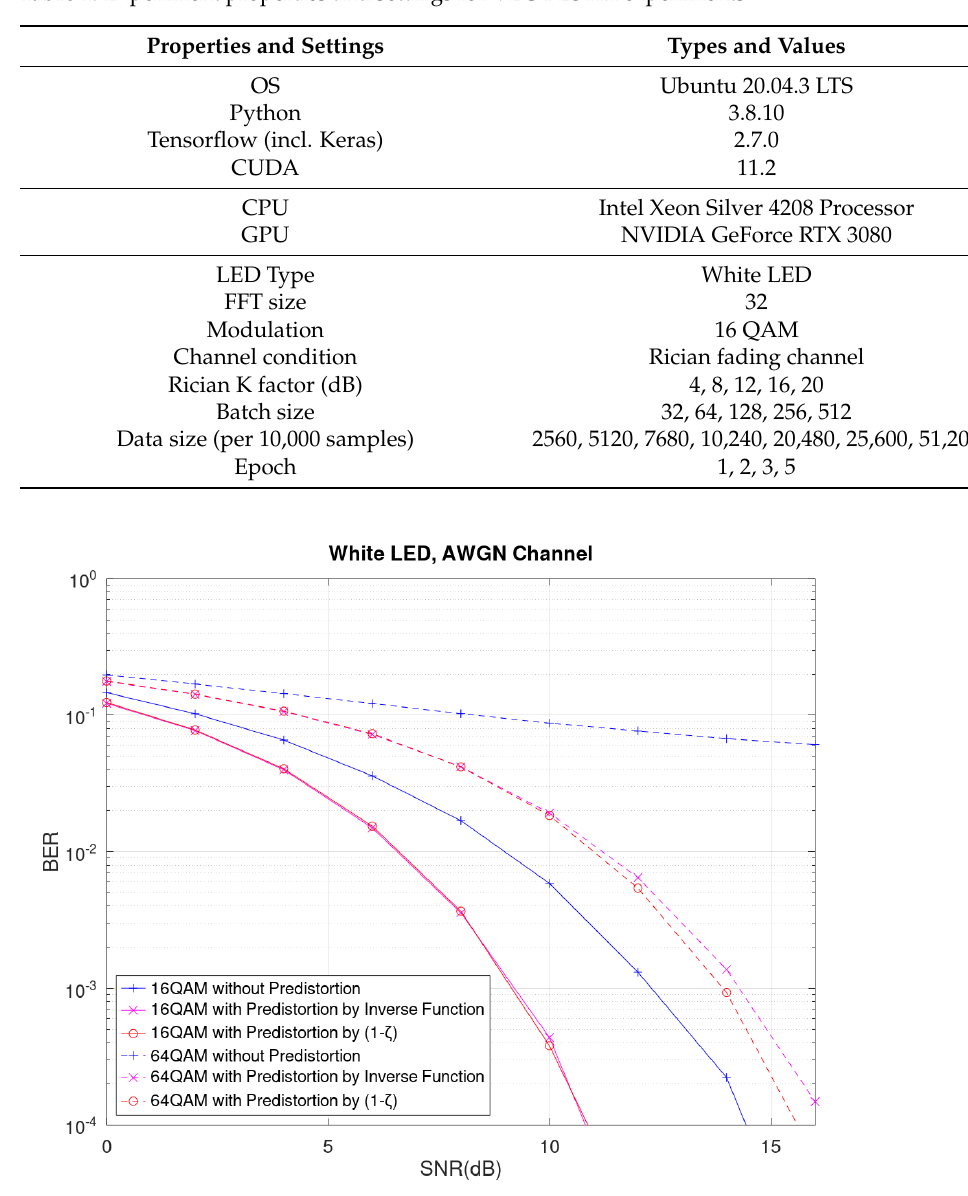
Figure 8. BER performances of the predistortion in 16/64 QAM modulation for white